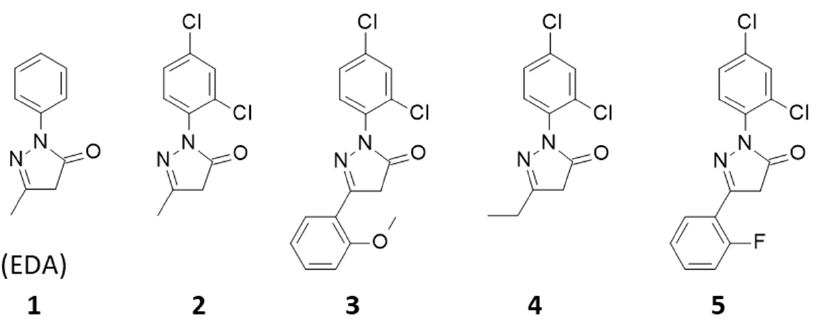
Figure 1. Structures of compounds 1 – 5